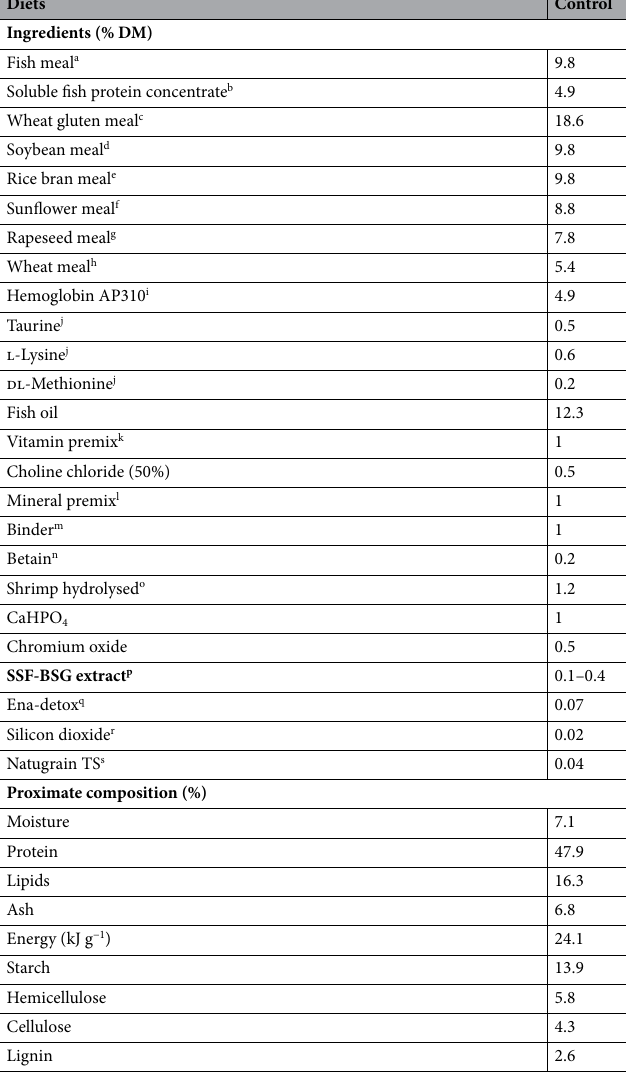
Table 2. Composition and proximate analysis of all experimental diets. CP: Crude protein; CL: Crude lipids; DM: Dry matter. a Steam Dried LT-FM, Pesquera Centinela, Chile (CP: 71.2%; CL 11.1%). b Sopropèche G, France (CP: 79.7%; CL: 18.4%DM). c Sorgal, S.A. Ovar, Portugal (CP: 86.9%; CL: 1.0%). d Sorgal, S.A. Ovar, Portugal (CP: 53.8%; CL: 1.8%). e Sorgal, S.A. Ovar, Portugal (CP: 14.1%; CL: 1.0%). f Sorgal, S.A. Ovar, Portugal. (CP: 29.0%; CL: 1.8%). g Sorgal, S.A. Ovar, Portugal. (CP: 41.5%; CL: 1.9%). h Sorgal, S.A. Ovar, Portugal. (CP: 12.4%; CL: 0.9%). i APC Europe S.A.S.A. (CP: 94.5%; CL: 0.4%). j Feed-grade taurine, l-lysine and dl-Methionine, Sorgal, S.A. Ovar, Portugal. k Vitamins (mg kg −1 diet): retinol, 18,000 (IU kg −1 diet); calciferol, 2000 (IU kg −1 diet); alpha tocopherol, 35; menadion sodium bis., 10; thiamin, 15; riboflavin, 25; Ca pantothenate, 50; nicotinic acid, 200; pyridoxine, 5; folic acid, 10; cyanocobalamin, 0.02; biotin, 1.5; ascorbyl monophosphate, 50; inositol, 400. l Minerals (mg kg −1 diet): cobalt sulphate, 1.91; copper sulphate, 19.6; iron sulphate, 200; sodium fluoride, 2.21; potassium iodide, 0.78; magnesium oxide, 830; manganese oxide, 26; sodium selenite, 0.66; zinc oxide, 37.5; dicalcium phosphate, 8.02 (g kg −1 diet); potassium chloride, 1.15 (g kg −1 diet); sodium chloride, 0.4 (g kg −1 diet). m LIPTOSA, Spain. n Sorgal, S.A. Ovar, Portugal. o Sorgal, S.A. Ovar, Portugal. (CP: 69.8%; CL: 12.1%). p Lyophilized extract obtained after solid-state fermentation of BSG with Aspergillus ibericus (xylanase and cellulase activities are, respectively, 15885 and 1343 U g −1 lyophilized extract). Incorporation levels: BSG0.1 diet—0.1%; BSG0.2 diet—0.2%; BSG0.4 diet—0.4%; BSG0.4 + diet— 0.4%. q Plant extract additive EUROPEAN NATURAL ADDITIVES, Madrid, Spain. Included in BSG0.4 + diet. r Silica+, CERESCO NUTRITION, Quebec, Canada. Included in BSG0.4+ diet. s Natugrain TS, BASF, Germany (2500 and 5600 U g −1 of cellulase and xylanase activity, commercial information). Included in NAT